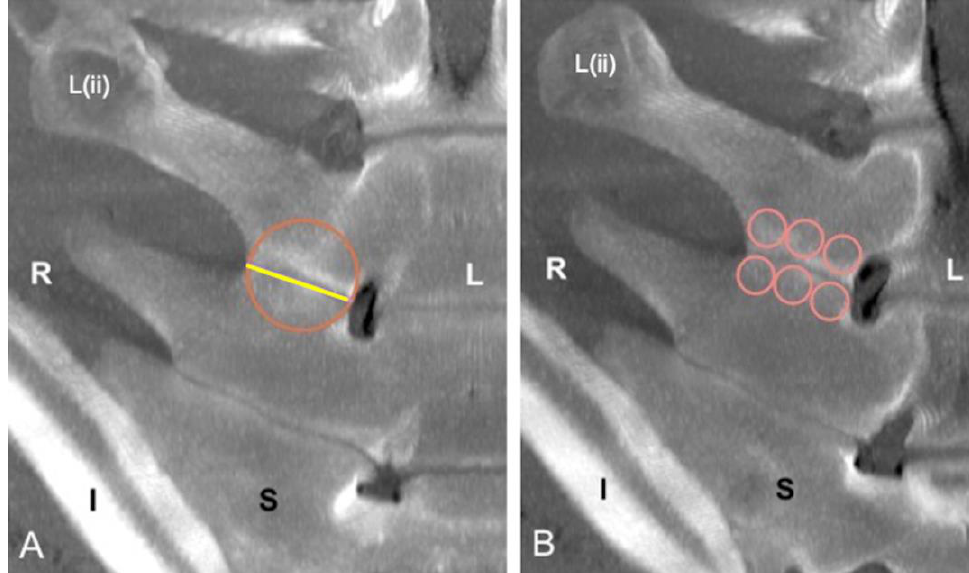
Figure 4. Dorsal multiplanar reconstruction computed tomographic images of the lumbosacroiliac specimen 40; cranial is toward the top of the images. ( A ) Measurement of the length of the right L(ii)-L(i) intertransverse joint (ITJ) and assessment of mean, minimum, and maximum Hounsfield unit (HU) and standard deviation of the periarticular surface by drawing a circle with a diameter equal to the length of the respective ITJ. ( B ) The right intertransverse periarticular bone surface of L(ii) and L(i) was divided into three sections (axial, middle, and abaxial part), and their respective mean HU was calculated by drawing on each part a small circle, with a diameter equal to one-third of the length of each ITJ. L: left; R: right; L(ii): second to the most caudal lumbar vertebra I: ilium; S: sacrum. Table 3. Number ( n ), prevalence (%), mean bone density expressed as Hounsfield Units (HU), and mean length (cm) of the most caudal lumbar intertransverse joints (ITJs) and degree of osseous pathological changes for 40 specimens that underwent post-mortem computed tomographic evaluation of the caudal lumbar region. L: left; R: right; B: bilaterally; S: symmetry; L(iv): fourth to the most caudal lumbar vertebra; L(iii): third to the most caudal lumbar vertebra; L(ii): second to the most caudal lumbar vertebra; L(i): the most caudal lumbar vertebra.